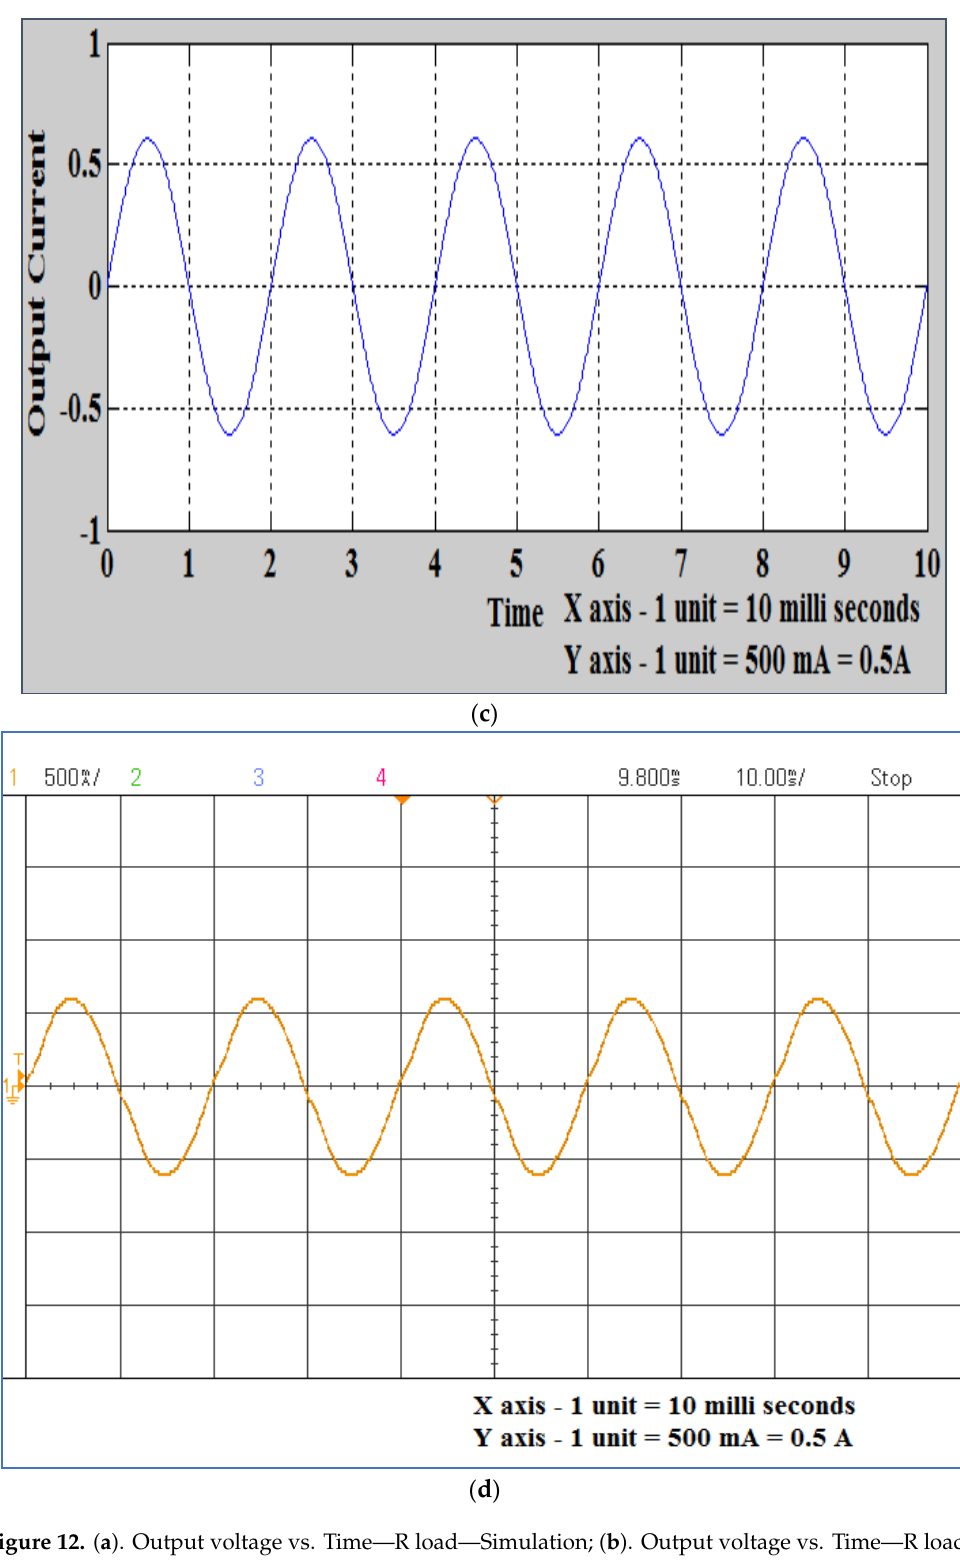
Figure 12. ( a ). Output voltage vs. Time—R load—Simulation; ( b ). Output voltage vs. Time—R load—Experimentation; ( c ). Output current vs. Time—R load—Simulation; ( d ). Output current vs. Time—R load—Experimentation.